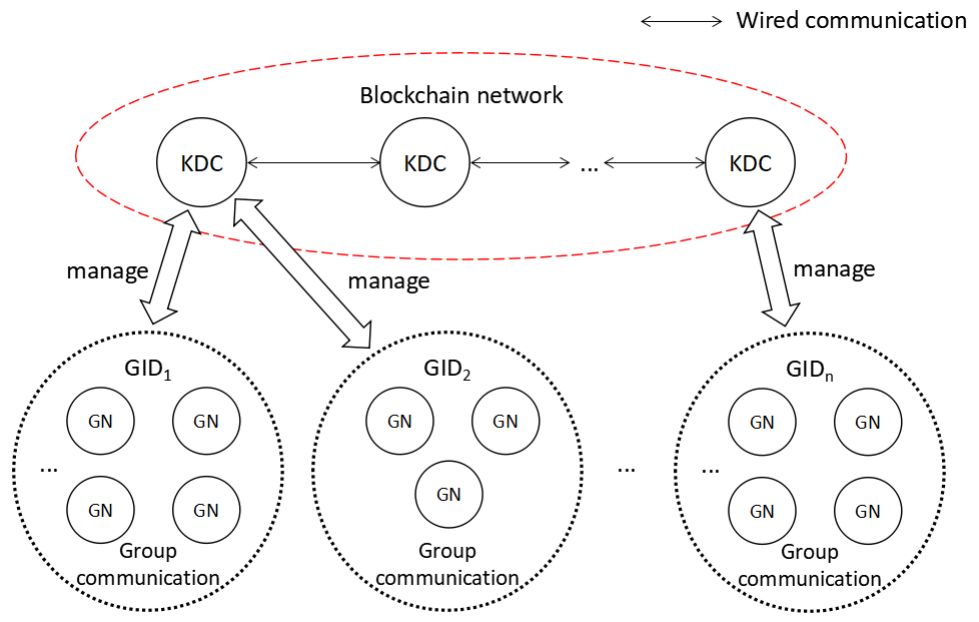
Figure 1. The network model used by our